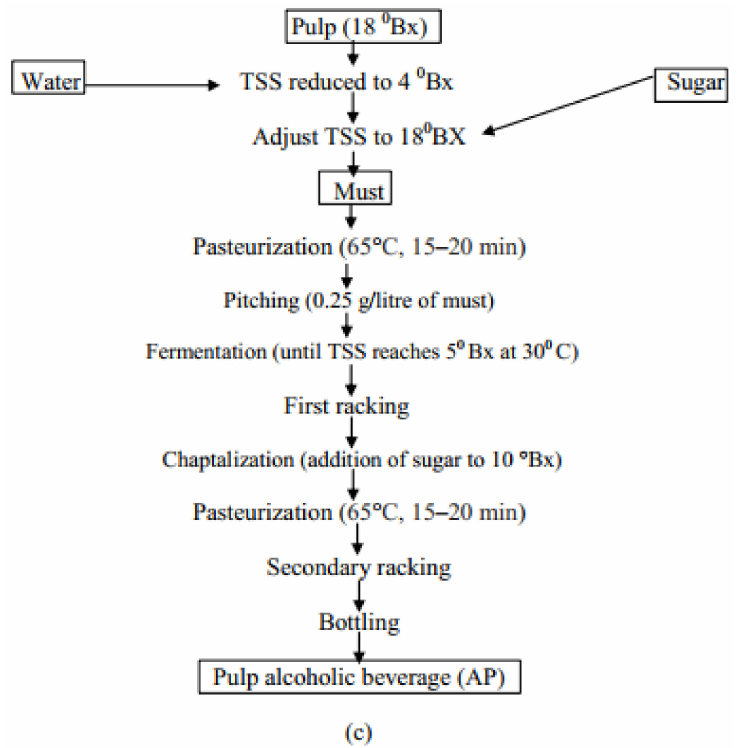
Figure 1. Flowchart for ( a ) mucilage extract alcoholic beverage (AM), ( b ) mucilage with seed alcoholic beverage (AMS), and ( c ) pulp alcoholic